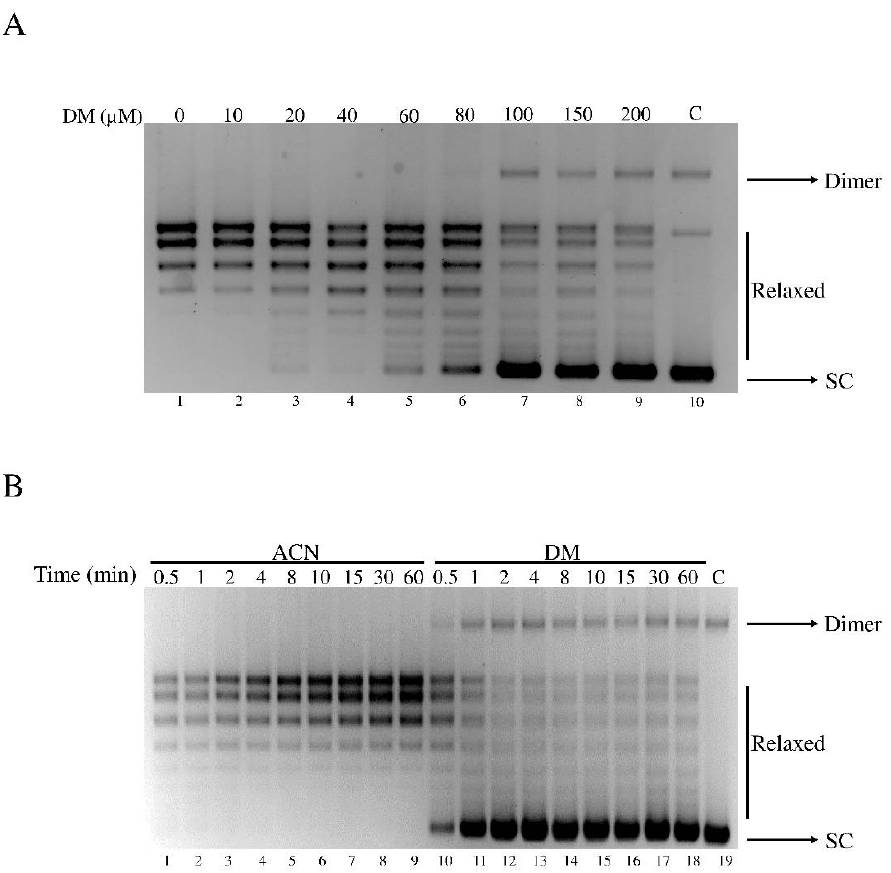
Figure 2. Inhibition of the catalytic activity of hTop1 by DM. ( A ) Relaxation assay in the presence of different concentrations of DM, ranging from 10 µ M to 200 µ M (lanes 2–9), performed in a dose- dependent manner. Samples were incubated in the presence and absence of DM and incubated for 1 h at 37 ◦ C, then were resolved on an agarose gel and stained with EtBr. Bands were visualized by a UV transilluminator. Lane 0 represents the positive control where the supercoiled DNA is incubated with the solvent and enzyme, lane 10 is the negative control with the supercoiled and DM only. ( B ) Time course assay in the presence of 100 µ M DM (lanes 10–19) or with the same amount of ACN (lanes 1–9). The results were analyzed on an agarose gel, stained with EtBr and visualized by a UV transilluminator.